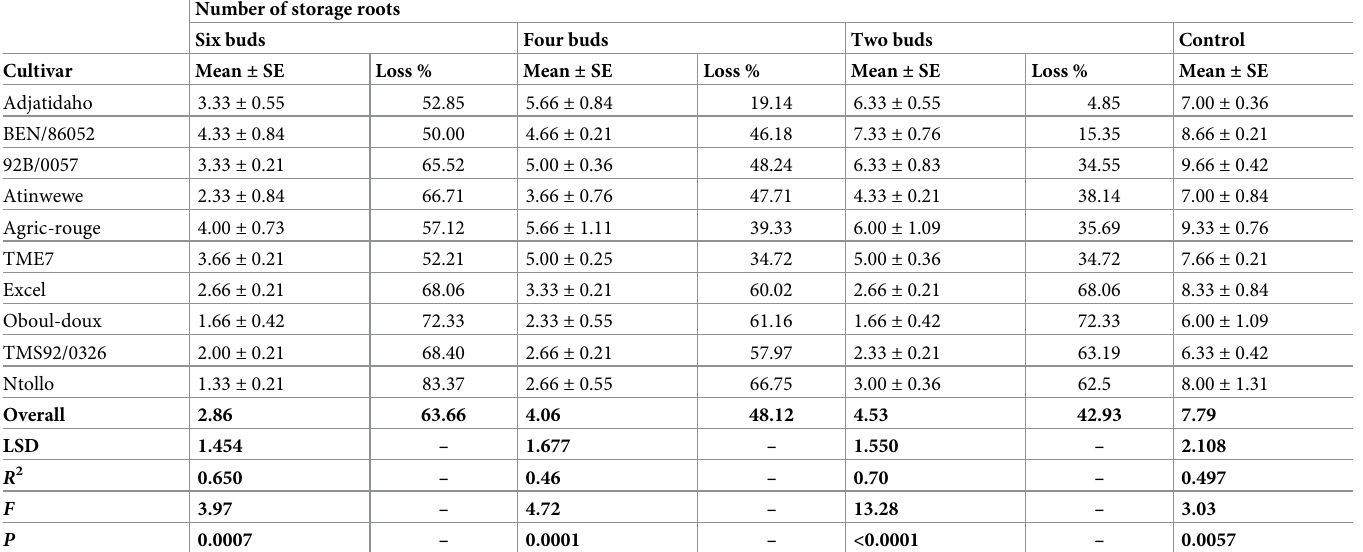
Table 4. Effect of viral dose (number of buds) on mean number of storage roots per plant. Number of storage roots